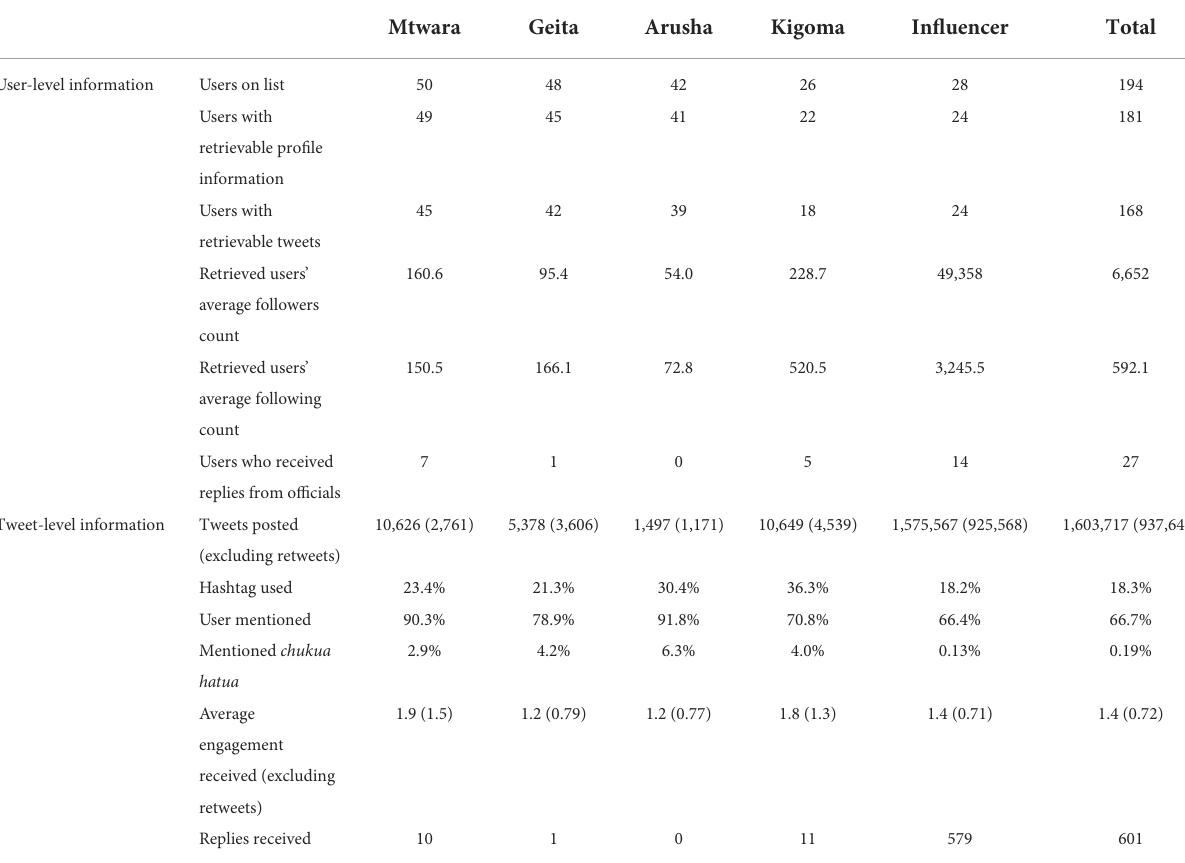
TABLE 3 Description of user and tweet